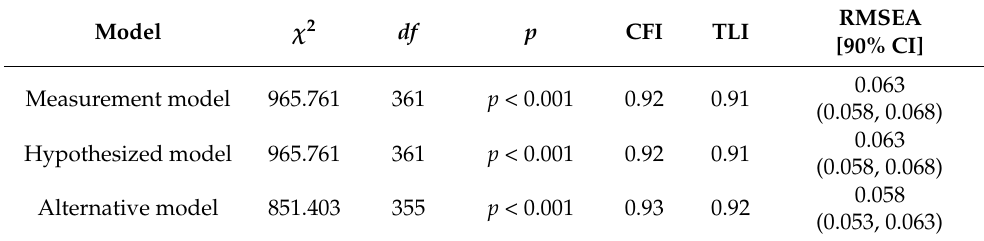
Table 3. Goodness of fit statistics of measurement, hypothesized, and alternative